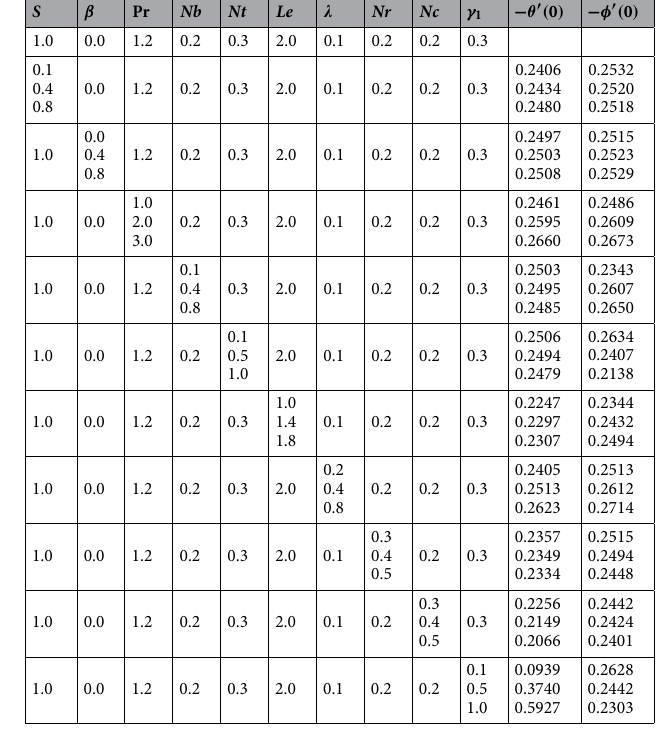
Table 1. Tabulations of − θ ′ ( 0 ) and − φ ′ ( 0 ) with variations of α , S , β , Pr, Nb , Nt , Le , (cid:31) , Nr , Nc and γ 1 .